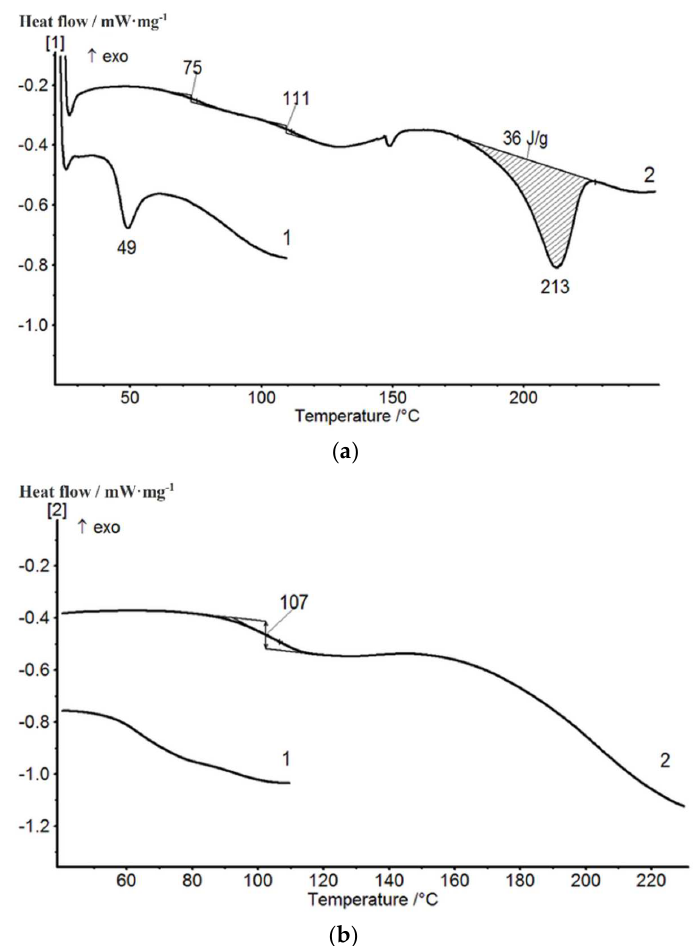
Figure 6. First and second DSC scans of PVA-PAA compositions: ( a )—composition 1 (mode 1: mixing